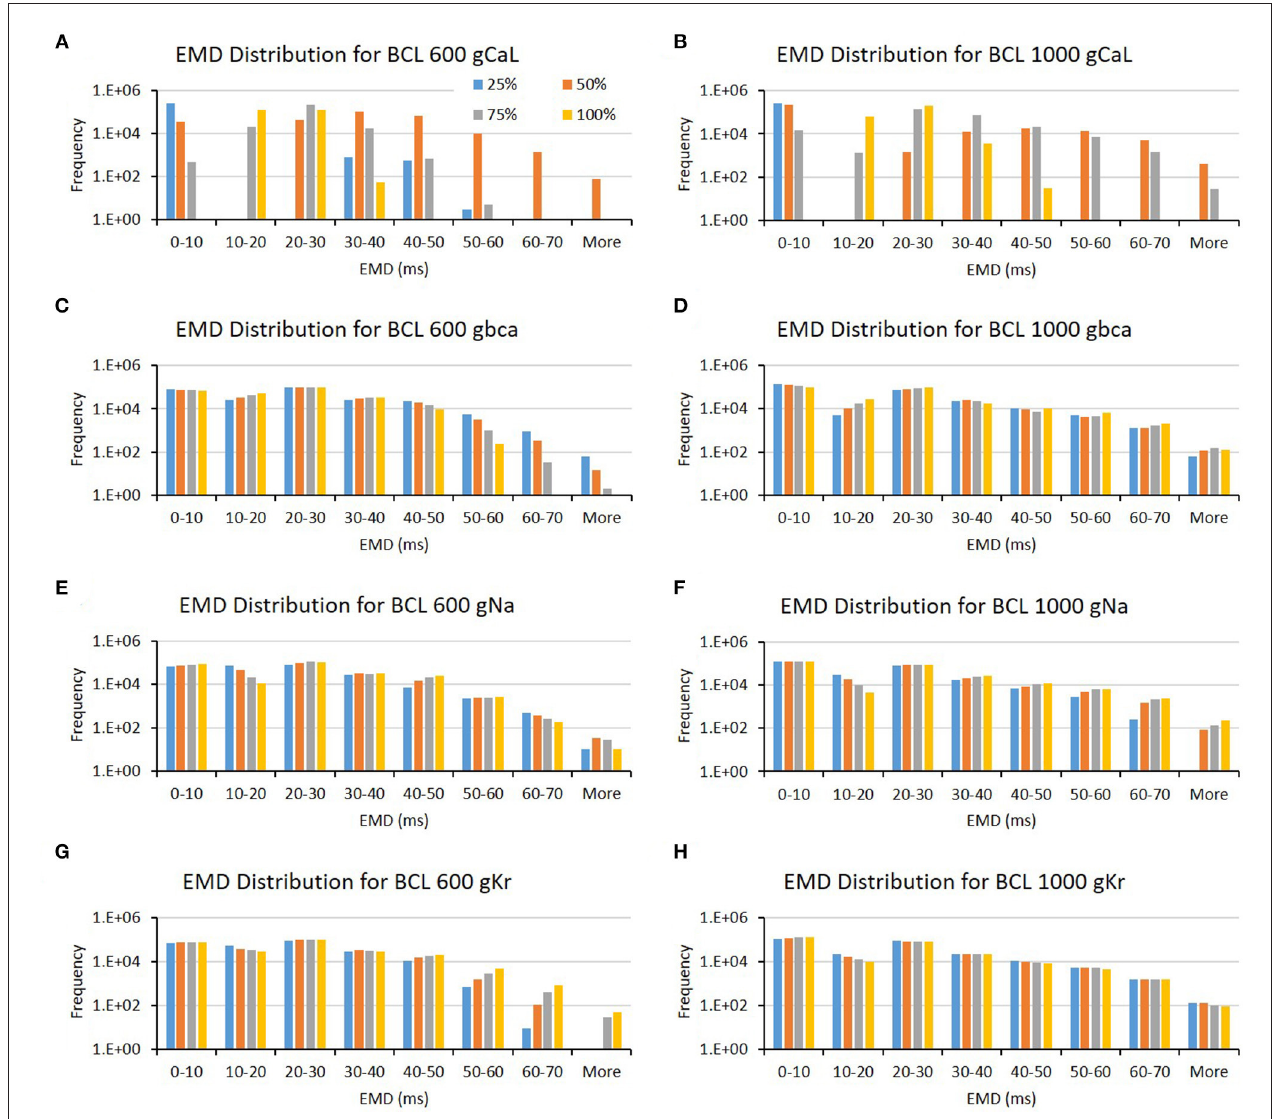
FIGURE 6 | The bar charts show the influence of major ion channels (based on Table 1 ) for increasing the EMD [for BCL 600ms (A,C,E,G) and for BCL 1,000ms (B,D,F,H) ]. The x-axis is the EMD groups in milliseconds, and the y-axis is the frequency (number of appearance of EMD groups) in logarithmic scale. Four conductance variations are applied